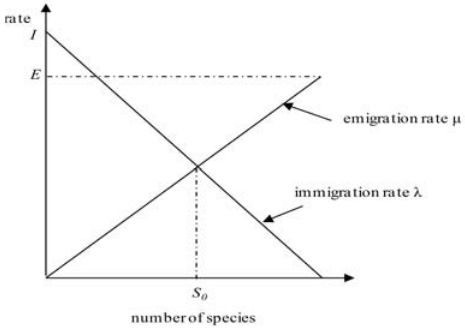
Fig. 2. Immigration and emigration curves of